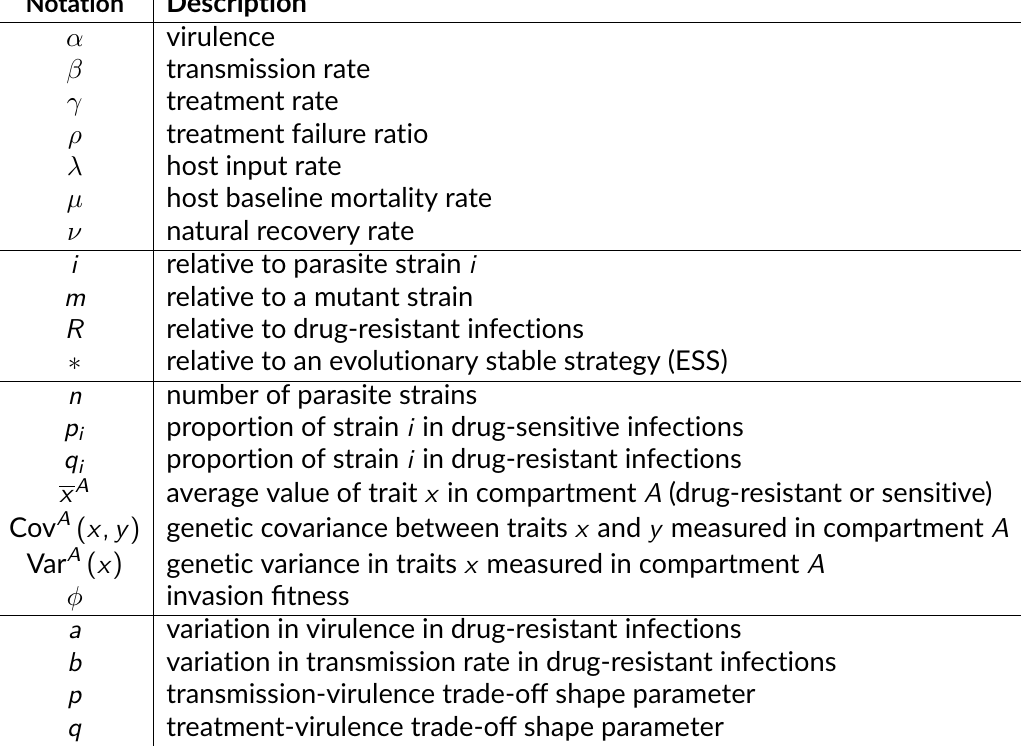
Table 1 – Model parameters and notations